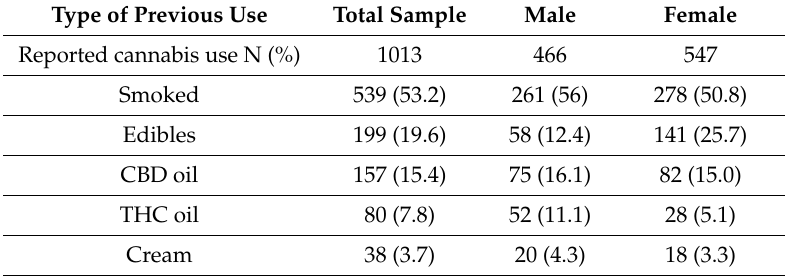
Table 3. Comparison of male and female self-reports of types of previous cannabis use.